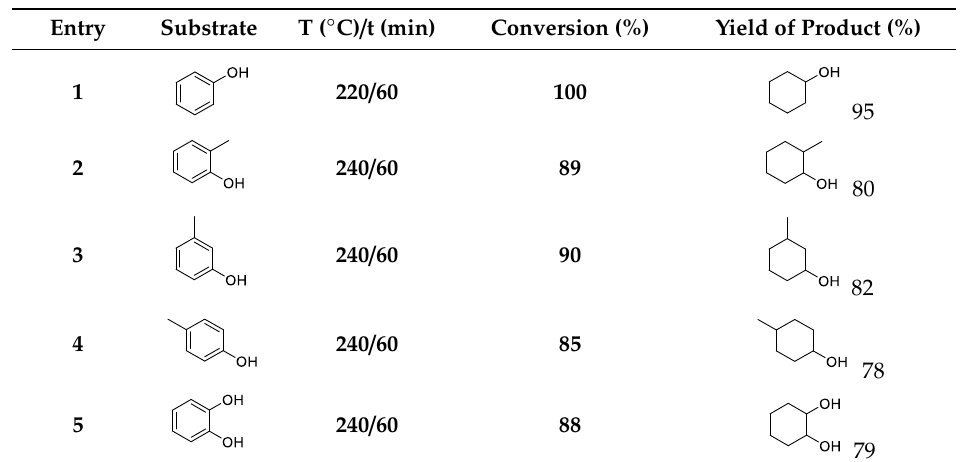
Table 4. Hydrogenation of phenol with substituted functional groups with 20% Ni / CNT in isopropanol a .